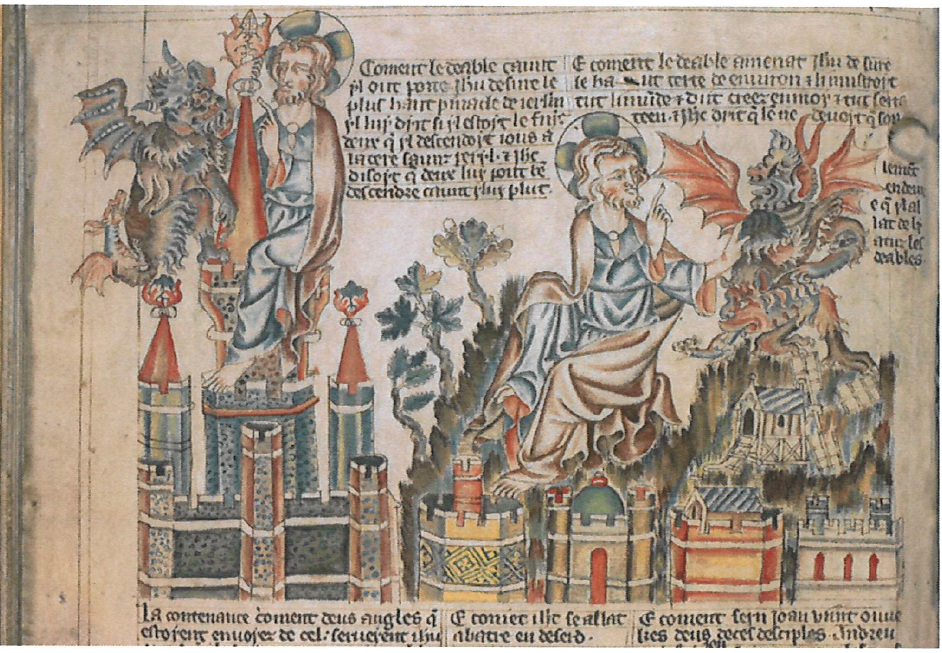
Fig. 10. Satan tempting Christ, c. 1327-35. The Holkham Bible, London, British Library, Add. MS. 47682, f.